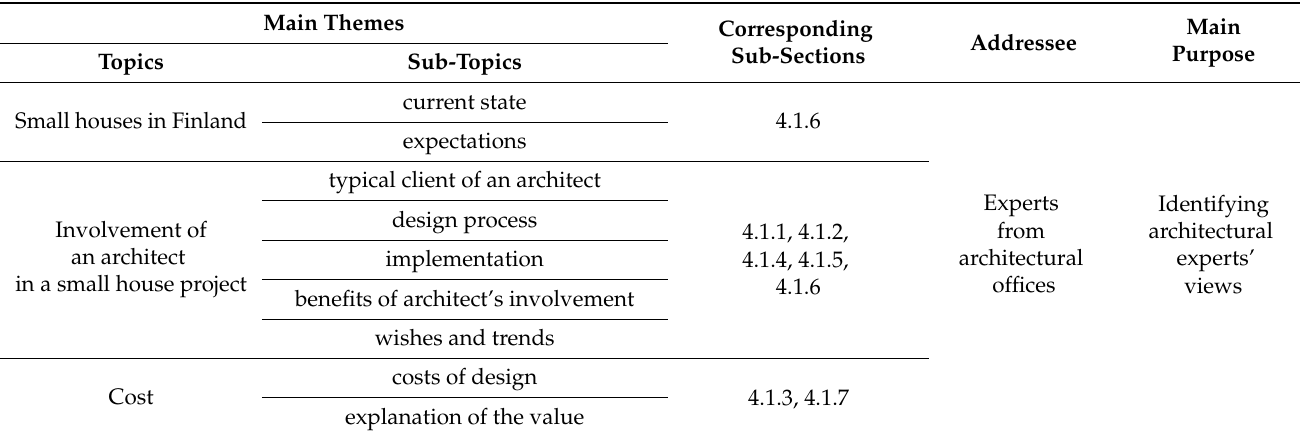
Table 4. The main themes, addressee, and main purpose of the interview questions (Appendix A.3).